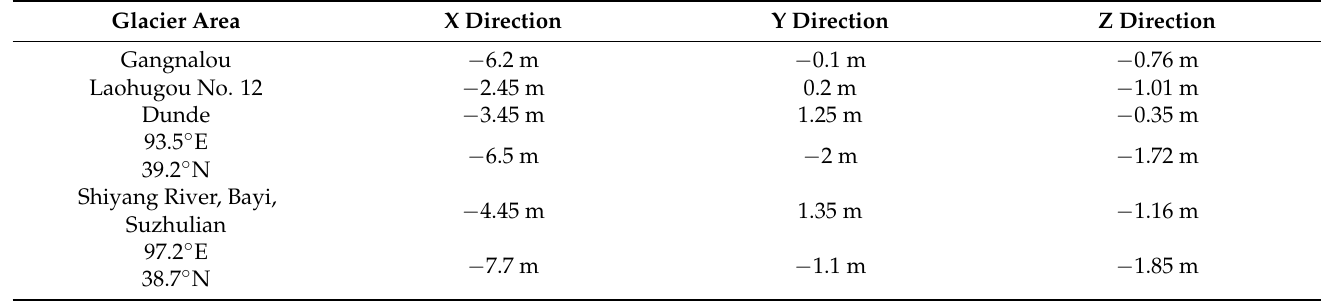
Table 2. Offset vector size. X direction offsets to the east are positive, and Y direction offsets to the south are positive.